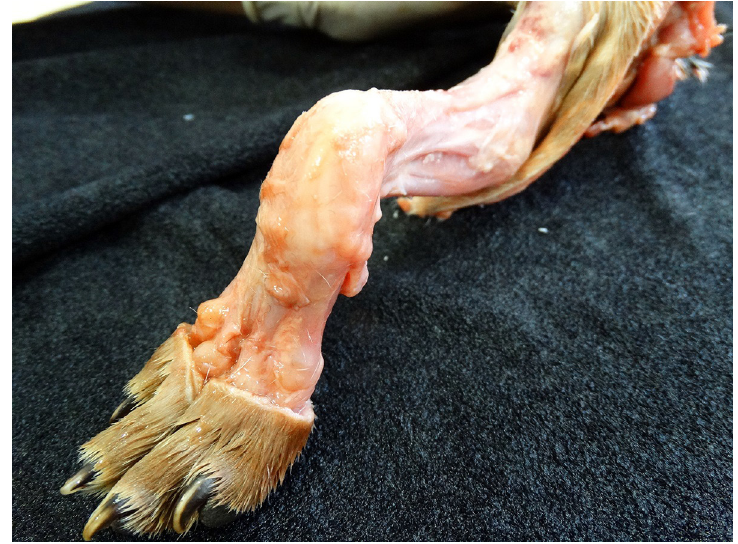
Figura 3. Membro torácico direito dissecado, evidenciando acentuada deformidade de estruturas esqueléticas e ligamentares.